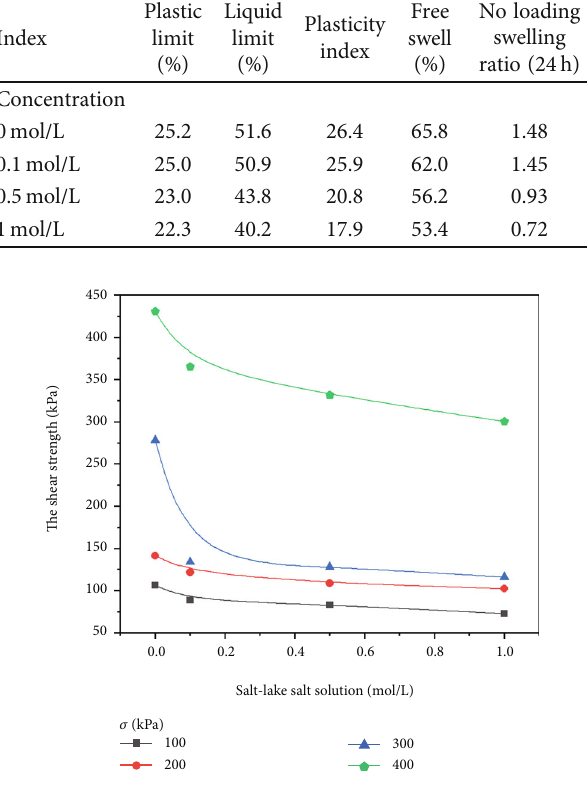
Figure 2: The relationship between shear strength and the concentration of SLS